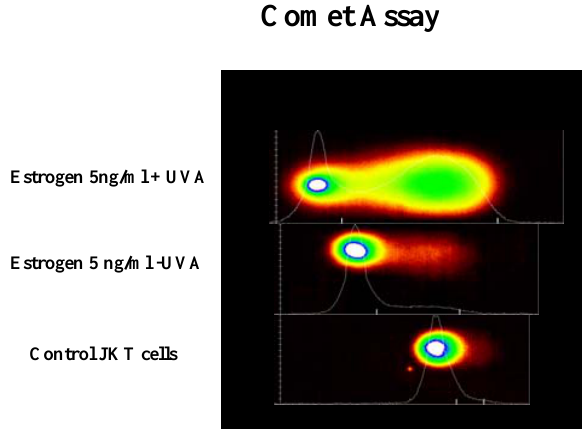
Figure 6: Comet assay of T cells treated with estrogen ± UVA where Y-axis is the Moment and x-axis is the different concentrations of estrogen used in comparison with controls which had no estrogen. DNA laddering was determined as shown in Figure 7. This shows that UVA exposure of estrogen treated cells does not alter DNA laddering of T cells.